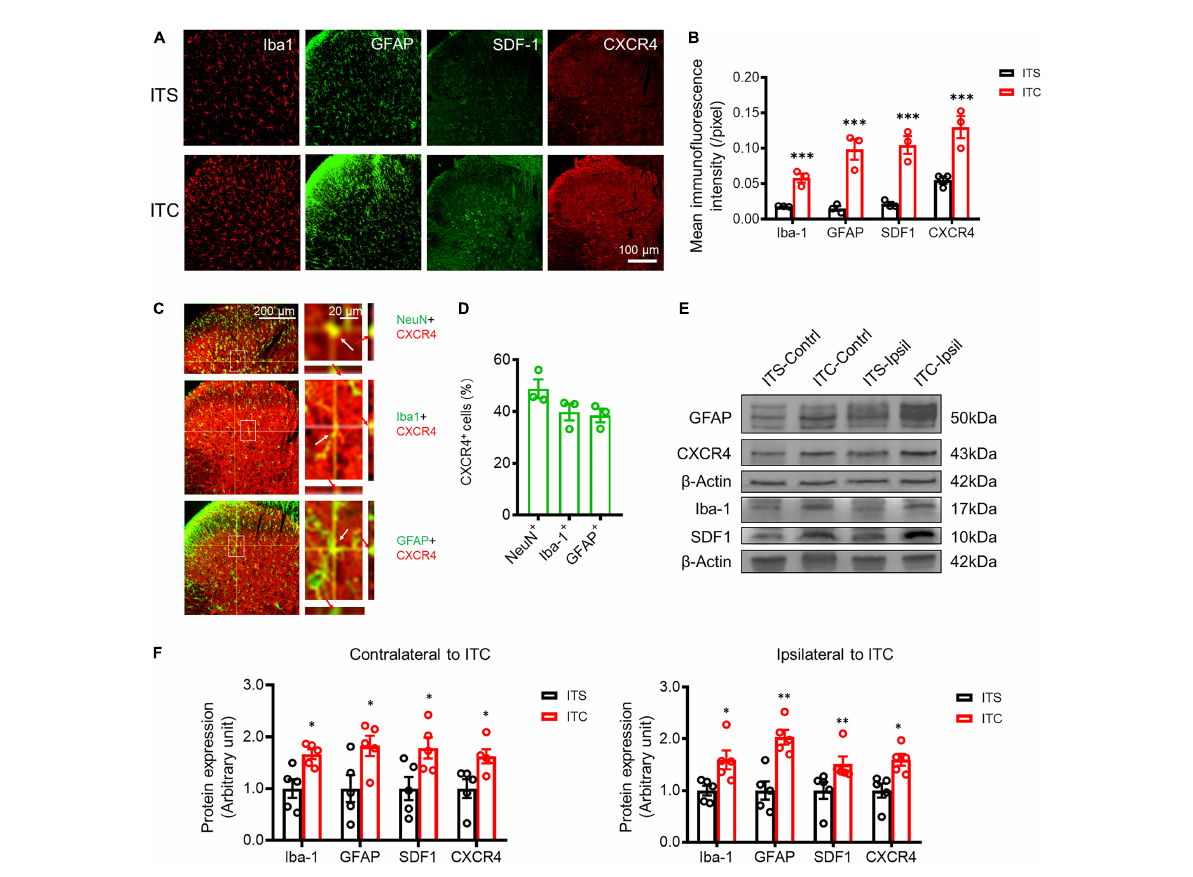
FIGURE3 Secondary neuroinflammation in the spinal dorsal horn 7 days after ITS or ITC. (A) Representative immunofluorescent photomicrographs showing the expression of Iba-1, GFAP, SDF1, and CXCR4 at the spinal dorsal horn contralateral to ITS or ITC. (B) Quantification of the mean immunofluorescent intensity of Iba-1, GFAP, SDF1, and CXCR4-labeled cellular profiles. *** p < 0.001 ITC vs. ITS, n = 3 rats/group. (C) Representative immunofluorescent photomicrographs showing co-localization of CXCR4 with NeuN, Iba-1, and GFAP-labeled cellular profiles at the spinal dorsal horn contralateral to ITC by orthogonal viewing method. (D) The percentage of CXCR4 in NeuN, Iba-1, and GFAP-labeled cellular profiles. (E) Western blot assay of Iba-1, GFAP, SDF1, and CXCR4 in bilateral dorsal spinal cord 7 days after ITS or ITC. (F) Quantitative analysis of the Western blot results for Iba-1, GFAP, SDF1, and CXCR4 in bilateral dorsal cord following 7 days after ITS or ITC. * p < 0.05, ** p < 0.01, ITC vs. ITS, n = 5 rats/group.